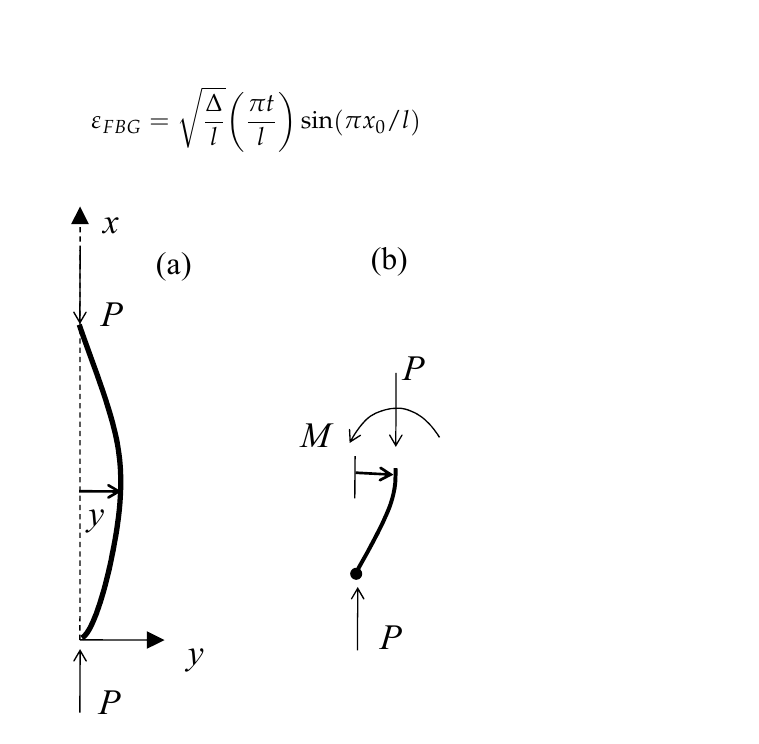
Figure 4. Working principle of the SDT: ( a ) deformed SDT; ( b ) force and moment balance within the SDT.